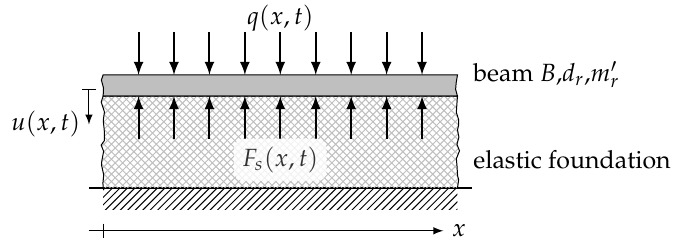
Figure 1. Infinite beam on an elastic foundation.